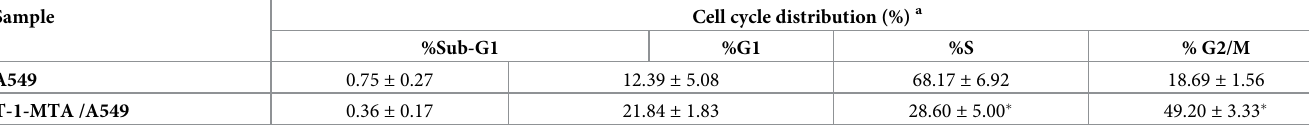
Table 6. Effect of T-1-MTA on the cell cycle of A549 cells after 72 h treatment.